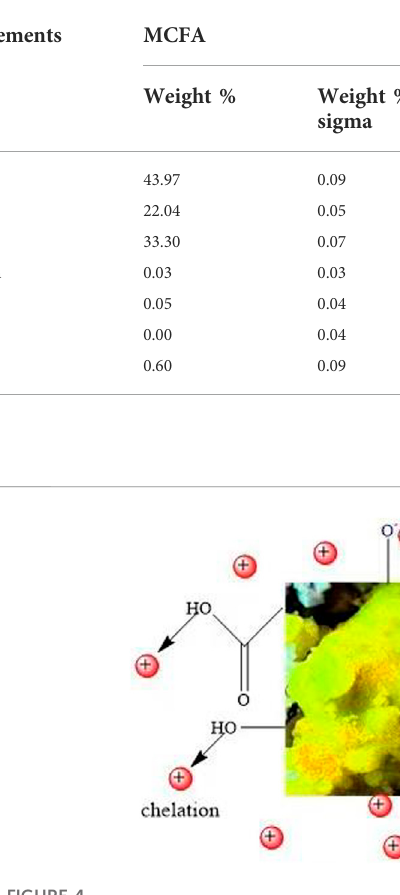
TABLE 1 Elemental composition of MCFA and MCFA-HM.